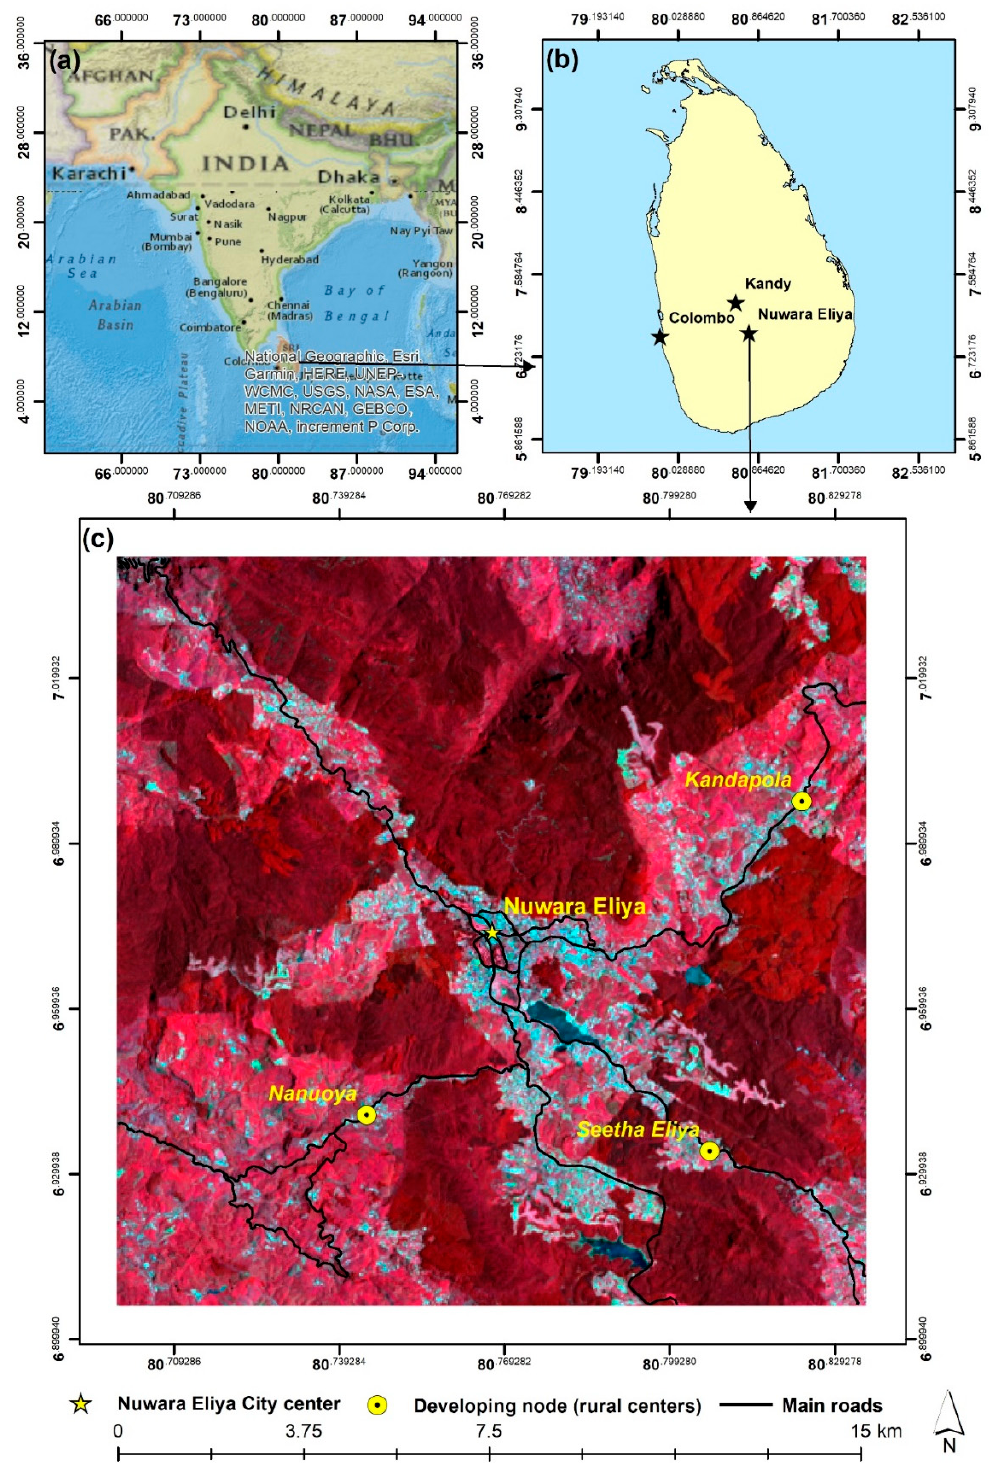
Figure 1. Location of the study area: ( a ) Map of South Asia; ( b ) Location of Nuwara Eliya Area; and ( c ) Landsat 8 image displayed in a false-color composite (bands 5, 4, and 3) (28 March 2017) [35].